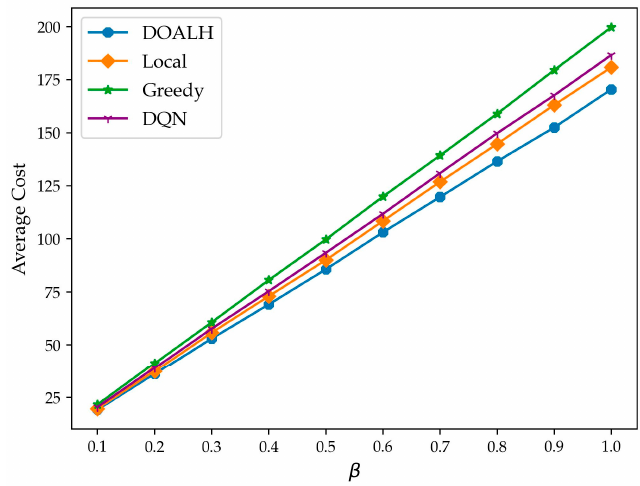
Figure 5. 𝑉 = 10, 𝑀 = 50, 𝐵 = 500 (Mb/s) Average 𝐶𝑜𝑠𝑡 vs. 𝛽 .